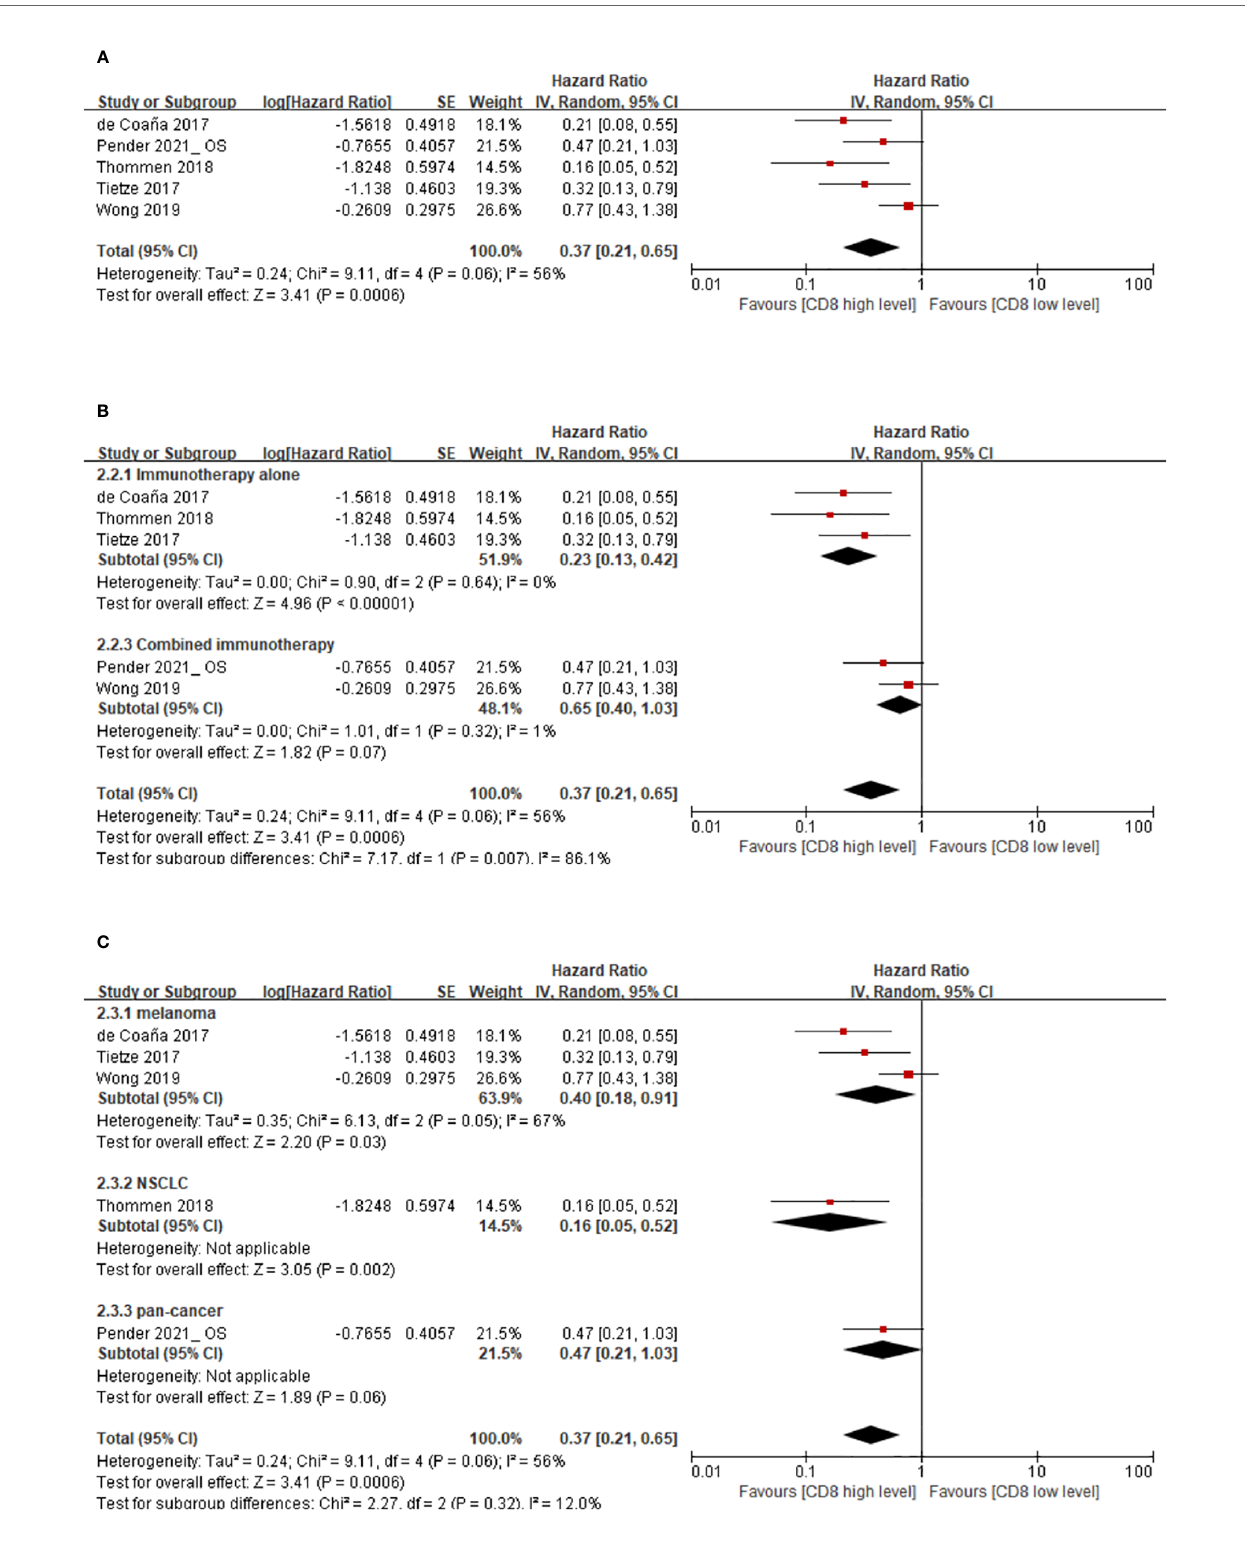
FIGURE 3 | (A) Florest plots of the random-effects meta-analysis for the effects of memory CD8(+) T cells on OS. (B) Florest plots of the random-effects meta- analysis for the effects of memory CD8(+) T cells on OS in different treatment regimens. (C) Florest plots of the random-effects meta-analysis for the effects of memory CD8(+) T cells on OS in different types of